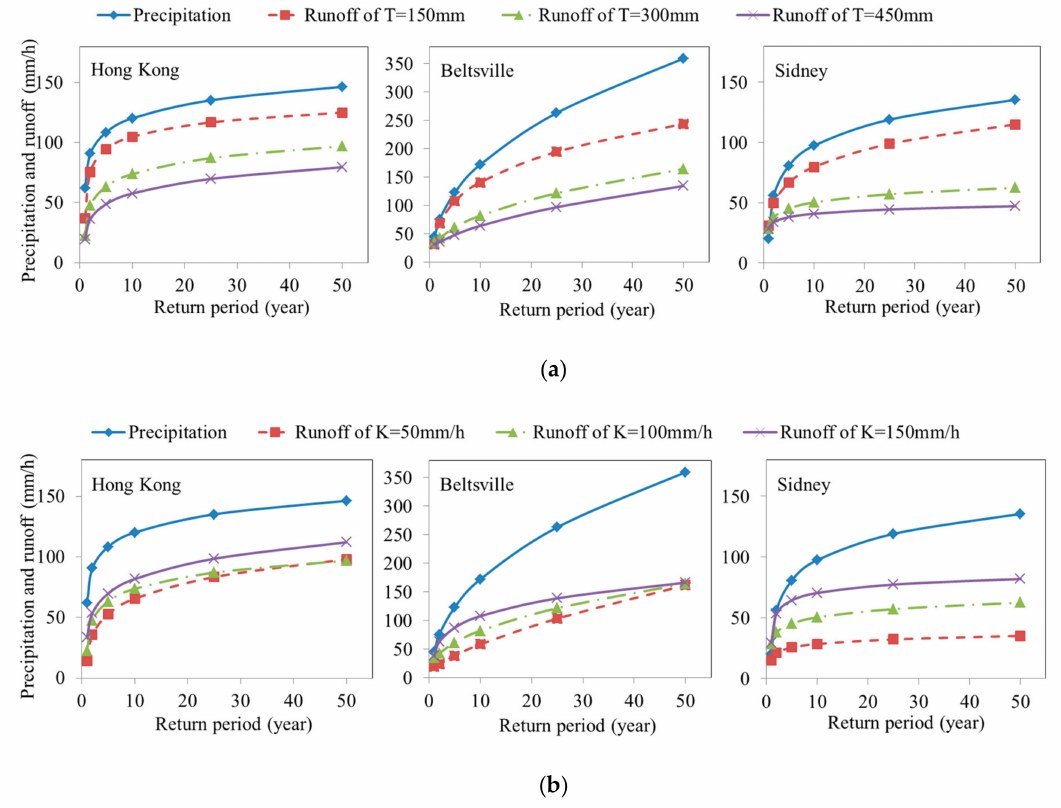
Figure 6. Peak runo ff of various green roofs di ff ering in ( a ) soil thickness (T) and ( b ) soil hydraulic conductivity (K). The conductivity in ( a ) is 100 mm / h, and the thickness in ( b ) is 300